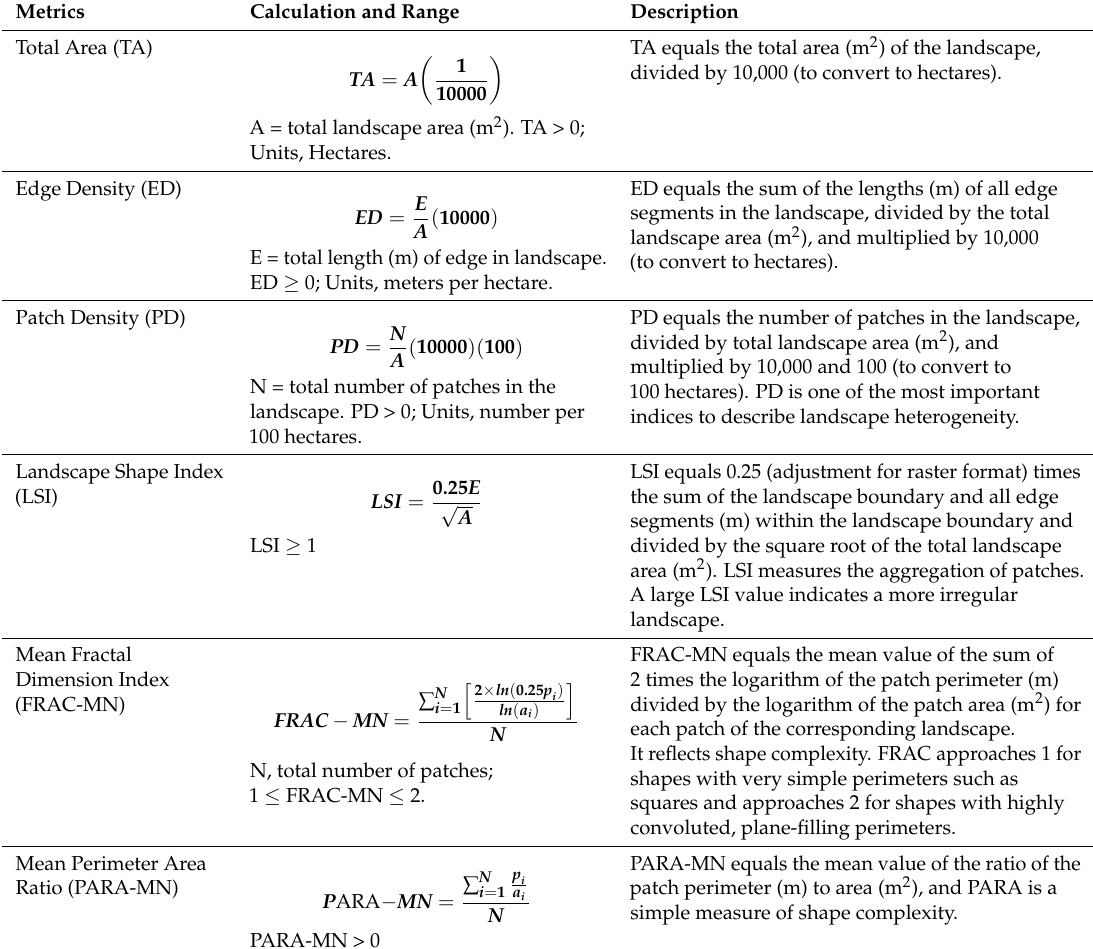
Table 1. List of landscape metrics and their